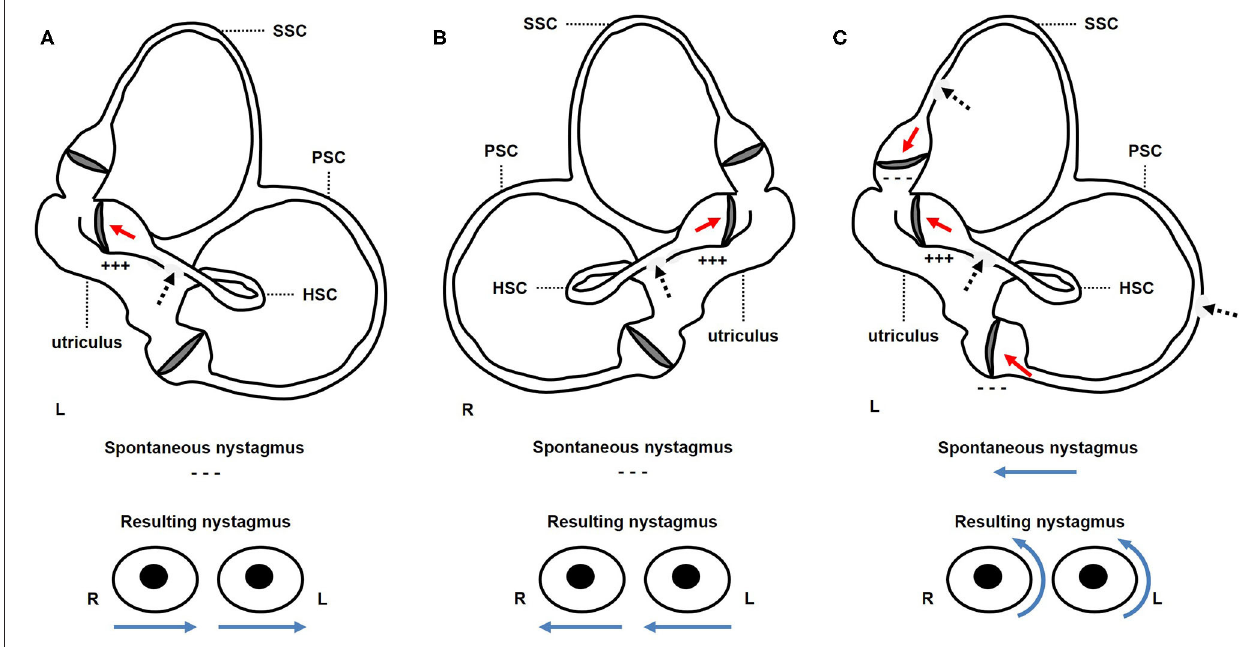
FIGURE 4 | Schematic representation of the membranous labyrinth along the sagittal plane ( above ) to explain the proposed mechanism for pressure-induce eye movements ( below ) in each case. Positive pressure applied over the EAC is represented with black dashed arrows , resulting in endolymphatic flows with red arrows and direction of nystagmus fast phase with blue arrows. (A) In the first case, positive pressure applied on the left EAC resulted in ampullopetal endolymphatic flows within left dehiscent HSC, leading to transitory excitation ( + + + ) of left HSC afferents. As there were no spontaneous nystagmus, resulting nystagmus was purely horizontal left-beating. (B) Likewise, in the second patient, right tragal compression led to ampullopetal excitatory ( + + + ) endolymphatic flows within right HSC resulting in transient horizontal right-beating nystagmus. (C) In the third case, positive pressure exerted over the patient’s left EAC generated simultaneous ampullopetal endolymphatic flows within each dehiscent canal, being excitatory ( + + + ) for left HSC and inhibitory for left PSC and SSC ( − − − ). While horizontal left-beating components coming from left HSC activation opposed to ongoing spontaneous paretic nystagmus, vertical components generated by vertical canal inhibition (upbeat and downbeat for SSC and PSC, respectively) reciprocally canceled. Then, resulting nystagmus mainly reflected torsional rightbeating components coming from inhibition of left vertical canals afferents. EAC, external auditory canal; HSC, horizontal semicircular canal; L, left; PSC, posterior semicircular canal; R, right; SSC, superior semicircular